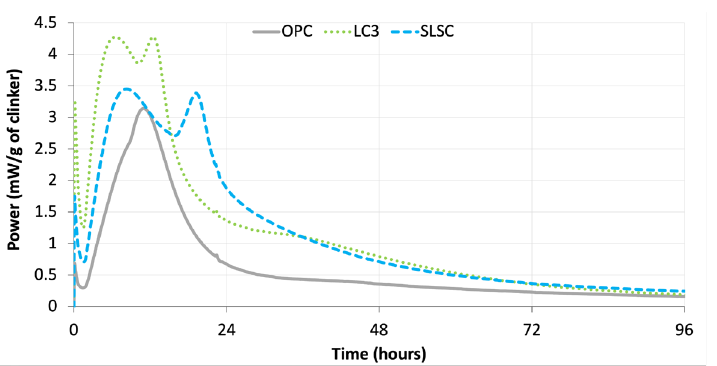
Figure 2. Heat flow plot for OPC, LC 3 and SLSC.